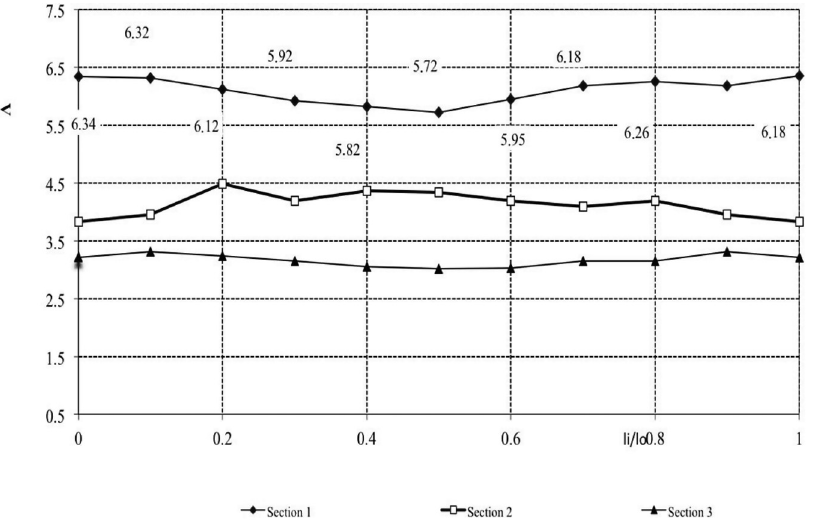
Figure 4: Distribution Λ on the longitudinal section of workpiece at a broach in the combined baizes with relative giving 0.6 (section 1 – D i / D ¼ 0.9; section 2 – D 0 D – length and diameter of the deformation center, 0